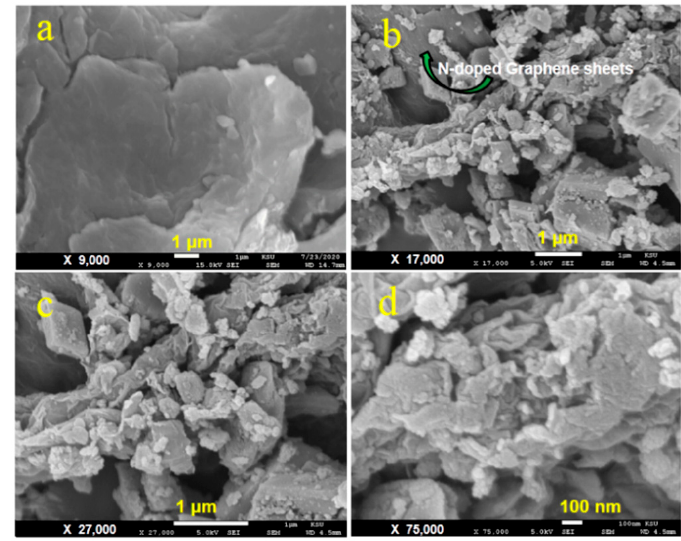
Figure 4. FE-SEM images of ( a ) NDG showing sheets like structures, and ( b – d ) (1%)NDG/MnCO 3 – (1%)ZrO 2 .